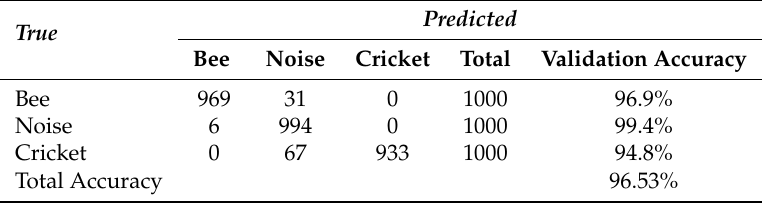
Table 20. Confusion matrix for RawConvNet with receptive field n = 80 on BUZZ2 validation dataset.